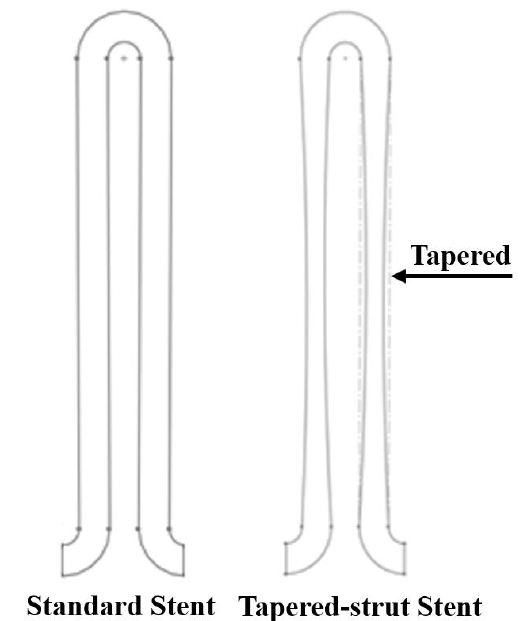
Figure 3. Tapered-strut stent design concept.